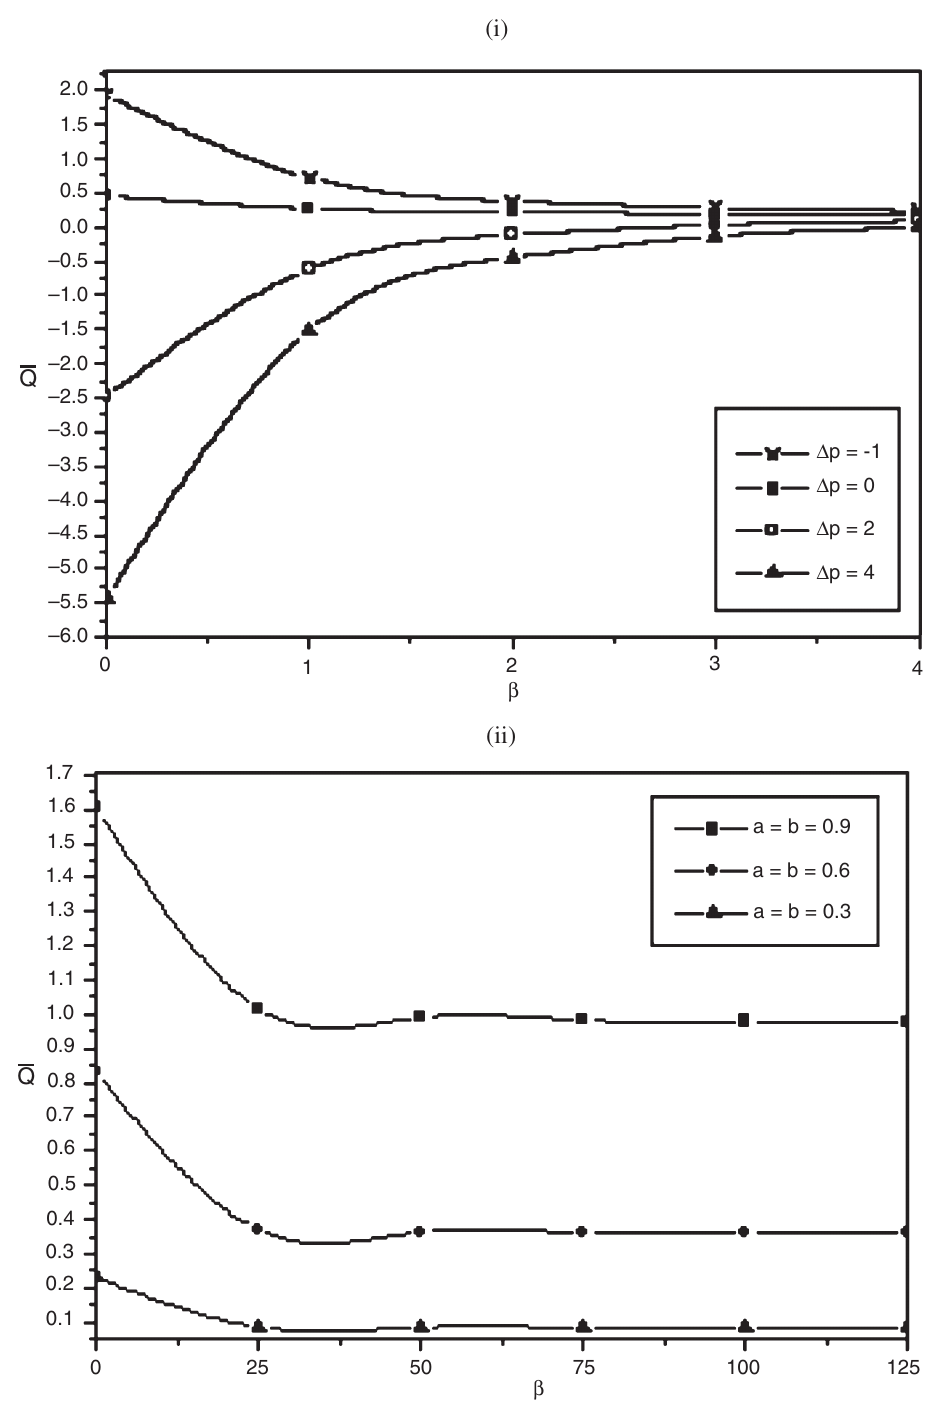
Fig. 6. (i) Variation of Q versus β with a = b = 0 . 7, d=2 and φ = π/ 2 for different values of (cid:9)p , and (ii) variation of Q versus β with free pumping ( (cid:9) p =0) for different a,b at d =1 and φ = π/